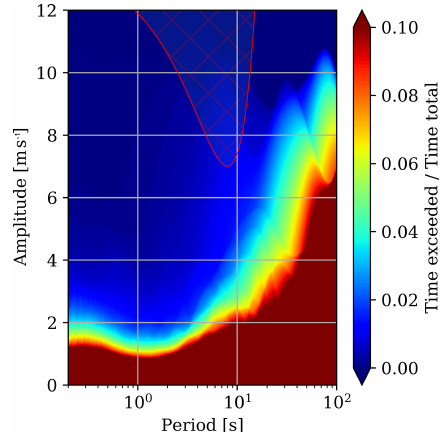
Figure 2. The 2-D contour plot shows the probability of a specific gust, defined by a distinct period and amplitude. The color contour encodes the probability that such a specific gust occurs or is ex- ceeded at any point within the original wind velocity signal shown in Fig. 1a. We call this 2-D information the characteristic gust dis- tribution of the signal in Fig. 1a. The hatched area in red at the top of the plot marks an exemplary dangerous gust zone of a fictitious